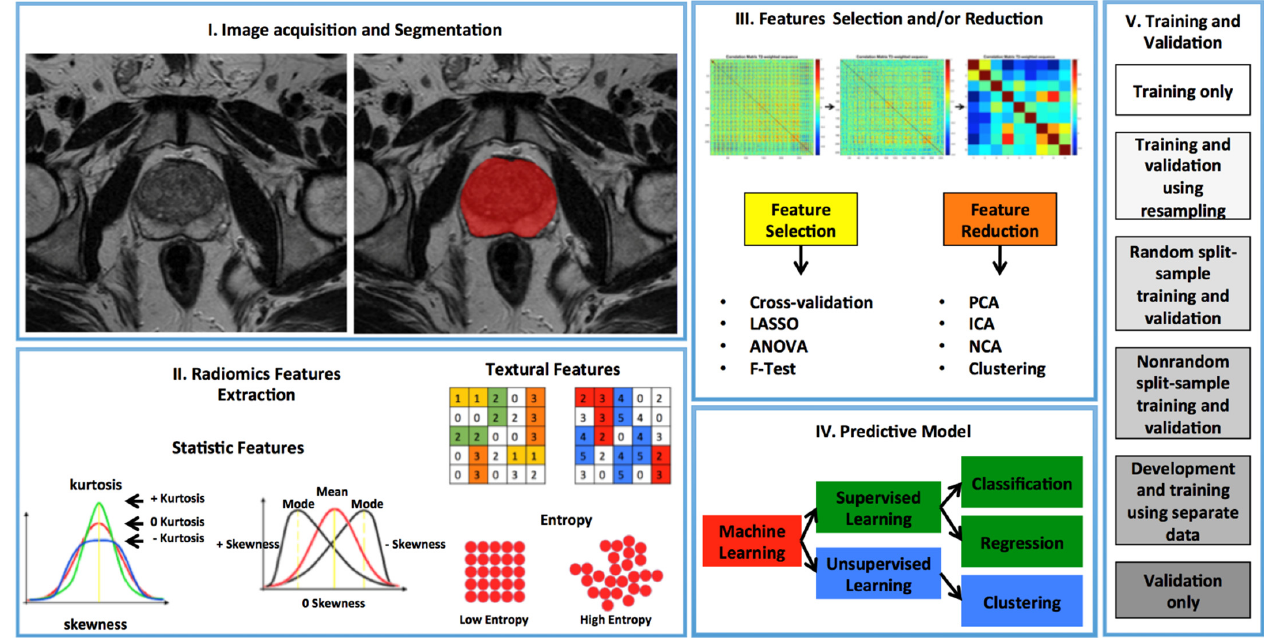
Figure 1. Radiomics workflow using artificial intelligence includes 5 steps: I . acquisition of radiological images and manual segmentation of the regions of interest (ROI); II . extraction of radiomics features from ROIs; III . methods of selection and/or reduction of the most significant radiomic features; IV . Artificial intelligence models for diagnosis prediction; V . Training and validation models.